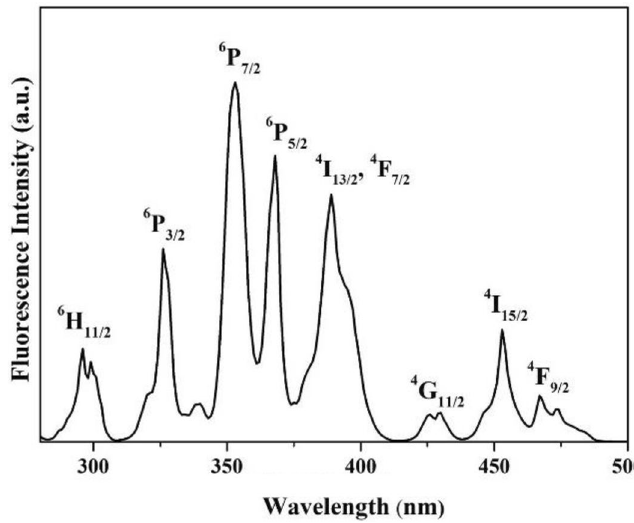
Figure 5. The excitation spectrum of Dy: CYA crystal.